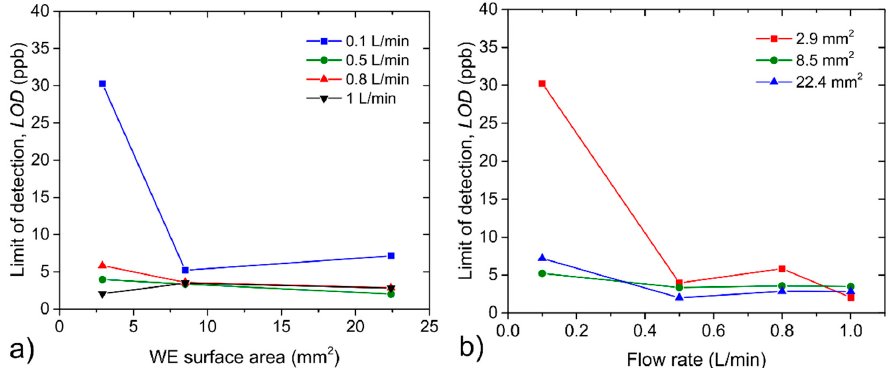
Figure 9. ( a ) Limit of detection (LOD) dependence on the WE surface area, ( b ) LOD dependence on the analyte flow rate. analyte flow